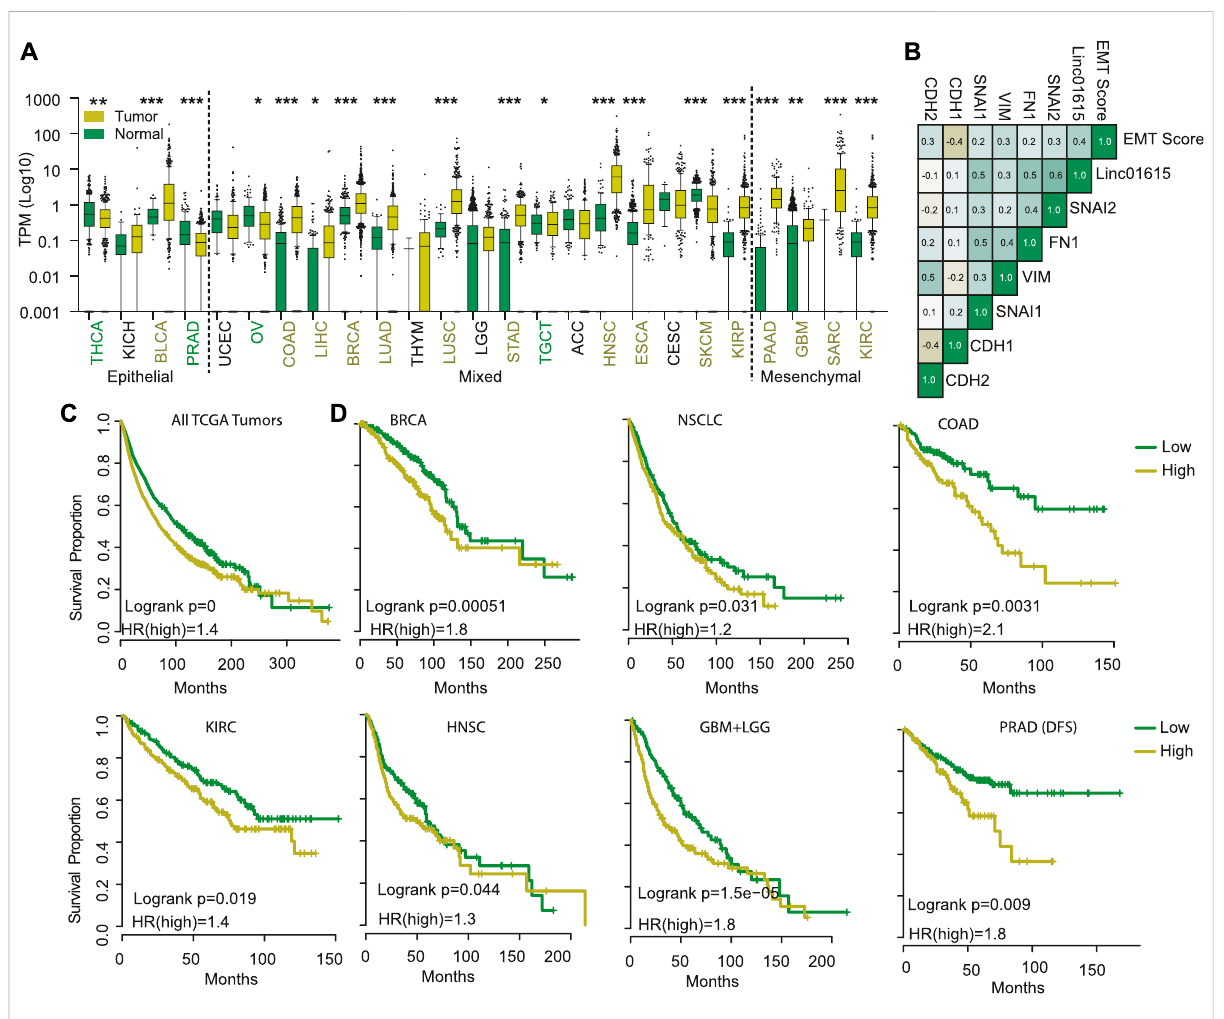
Linc01615 is a mesenchymal LncRNA. (A) The correlation of Linc01615 expression was done with EMT score and EMT markers and shown. (B) Expression of Linc01615 was compared in all the TCGA cancer types and plotted. (C) All the TCGA patients were combined and divided into patients with high and low Linc01615 expression, and a Kaplan-Meier analysis was performed. (D) Individual cancer types were divided into low and high Linc01615 groups, and survival was compared using Kaplan-Meier